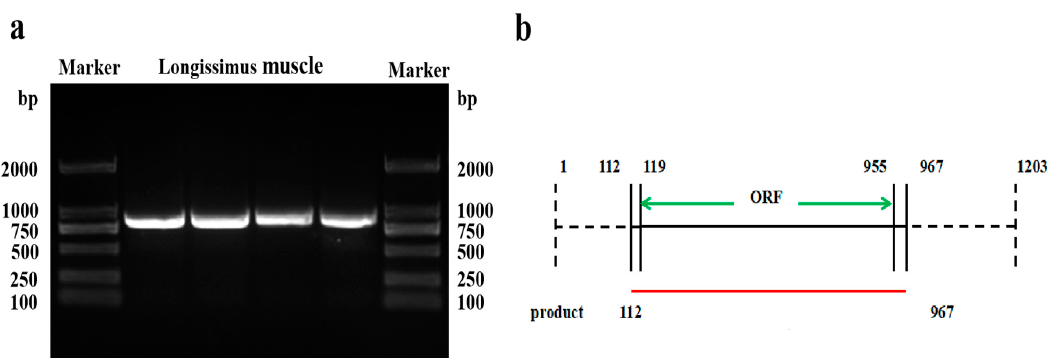
Figure 1. The p32 -coding sequence (p32 -CDS) primers were designed for amplifying the open reading frame (ORF) of p32 and the sketch of the p32 -CDS amplification product from Hu sheep ( b ). The four lanes represent p32 -CDS amplification product using the Longissimus muscle’s cDNA ( a ). The dashed line represents the untranslated region of p32 , and the green line represents the ORF of p32 .